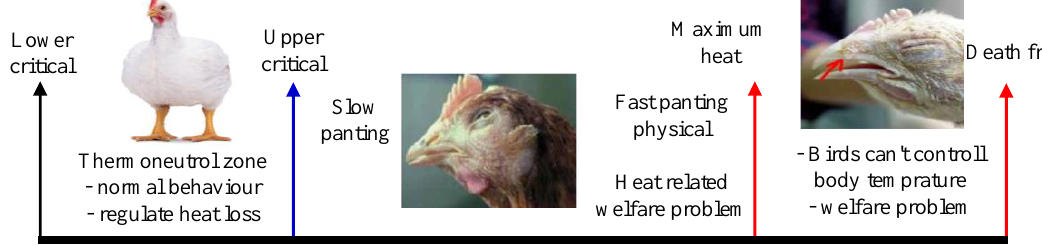
Figure 1. A simplified scheme showing thermoneutral zone of poultry birds.